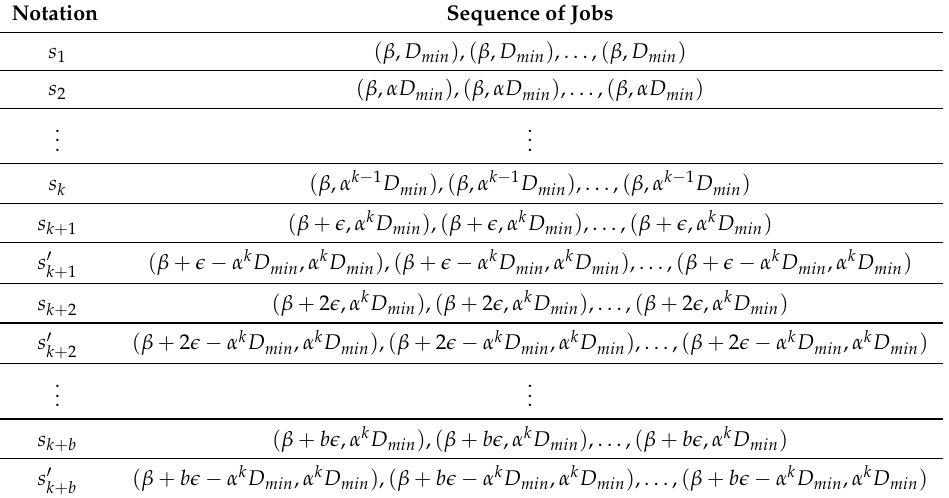
Table A1. Sequences s 1 , s 2 , . . . , s k + b and s (cid:48) represents a job, with the first value in the tuple being the start time of the job and the second value being the job’s duration. The jobs in the sequences are ordered by their arrival